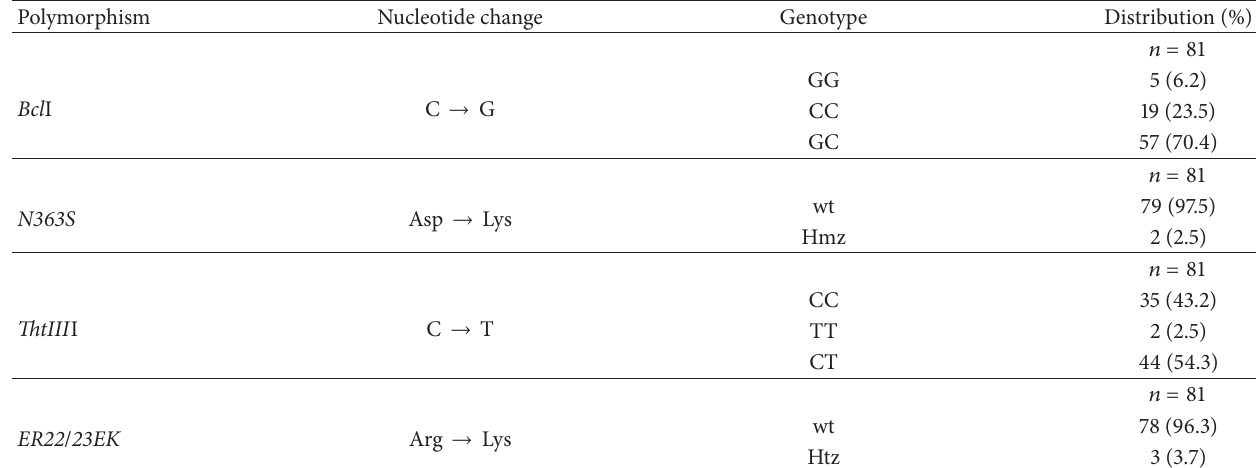
Table 3: Distribution of GR